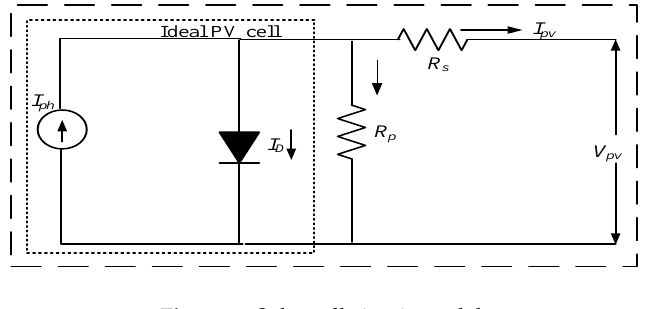
Figure 1. Solar cell circuit model.